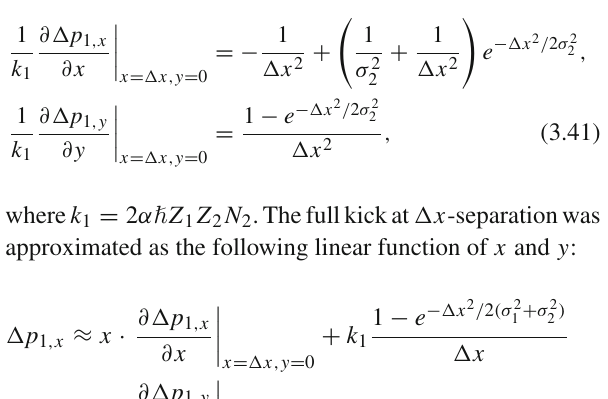
not taken from (2.10) or (2.12) but was approximated by a simple linear function of the x and y coordinates. The constant term was chosen to reproduce the orbit shift from (3.34). The slopes were taken from the derivatives ∂(cid:2) p 1 /∂ x , /∂ y at the first bunch center. The model was limited ∂(cid:2) p 1 to the case when the Gaussian bunches collided head-on cross-derivatives ∂(cid:2) p 1 , y /∂ x , ∂(cid:2) p 1 , x /∂ y vanish, and the x , y -slopes were taken as ∂(cid:2) p 1 , x /∂ x , ∂(cid:2) p 1 , y /∂ y ,